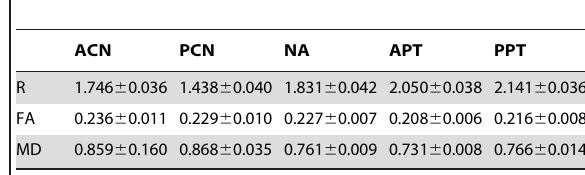
ACN: Anterior caudate nucleus, PCN: posterior caudate nucleus, NA: nucleus accumbens, APT: anterior putamen, PPT: posterior putamen, R: dopamine synthesis capacity, FA: fractional anisotropy, MD: Mean Diffusivity ( 6 10 2 3 mm 2 / s). doi:10.1371/journal.pone.0087886.t001 Figure 2. Age-adjusted Spearman’s correlation coefficient of